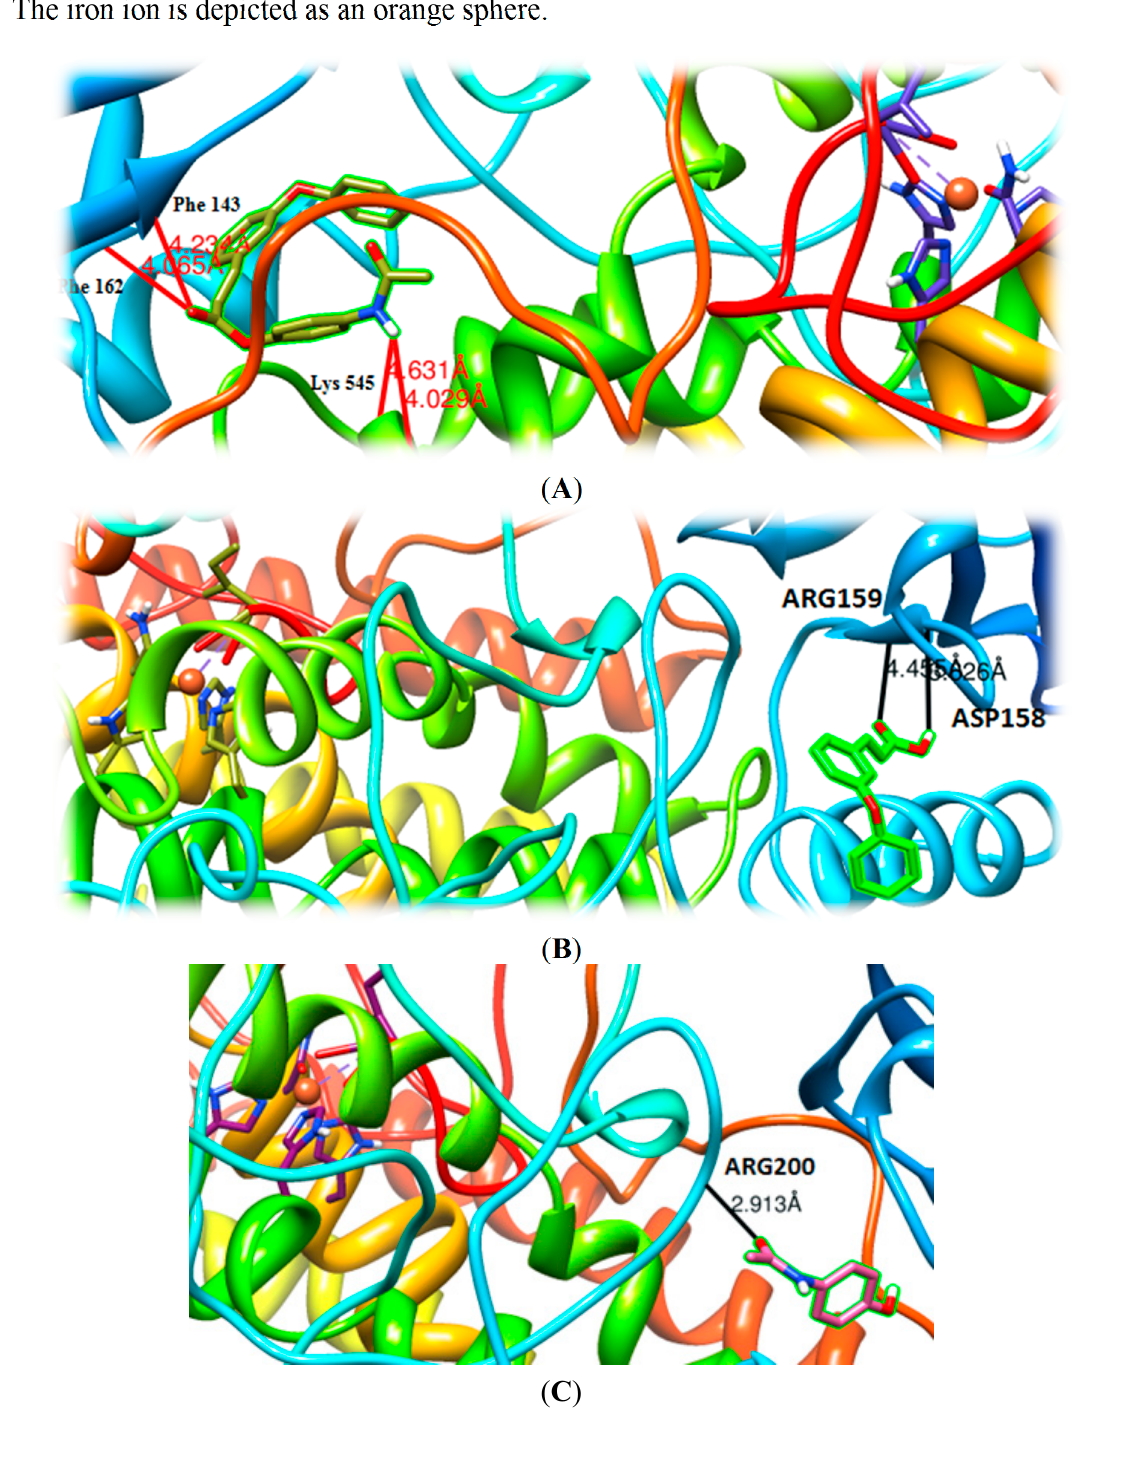
Figure 8. ( A ) Docked poses of hybrid 2a (in the LOX binding site. Ball and stick models are used to render the side-chains of relevant binding site residues. The iron ion is depicted as an orange sphere; ( B ) Docked poses of acid II in the LOX binding site. Ball and stick models are used to render the side-chains of relevant binding site residues. The iron ion is depicted as an orange sphere; ( C ) Docked poses of paracetamol in the LOX binding site. Ball and stick models are used to render the side-chains of relevant binding site residues. The iron ion is depicted as an orange